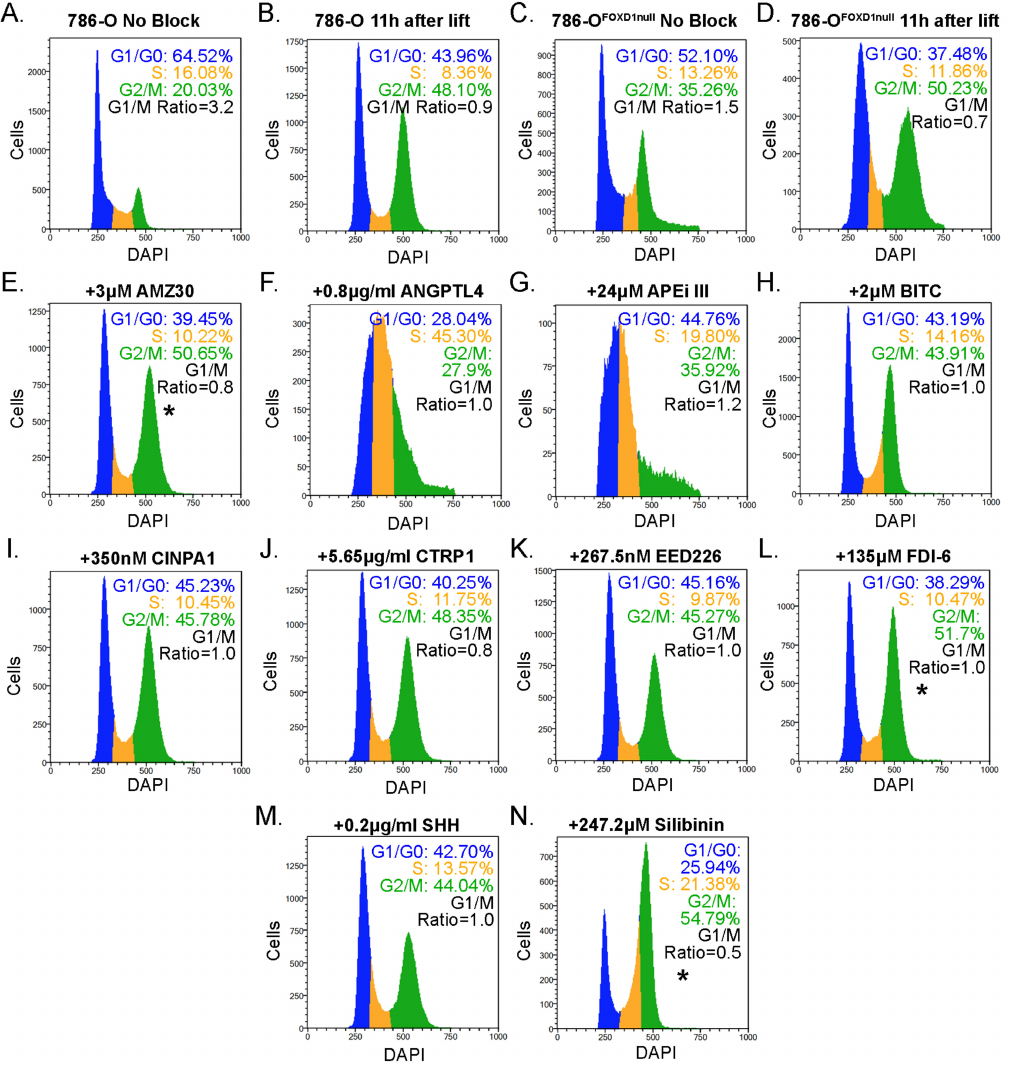
Figure 4. Synchronized cell cycle analysis identifies targets that inhibit G2/M progression. ( A – D ) untreated controls were compared to non-synchronized cells to confirm that the blocking and lifting strategy worked as predicted. ( E – N ) synchronized cells were treated with indicated treatment upon removal from the block and allowed to grow for 11 h. Fixed cells were analyzed for cell cycle distribution using DAPI, and the distribution of cells at G2/M was compared to untreated. * indicates p < 0.05 by a Student’s t